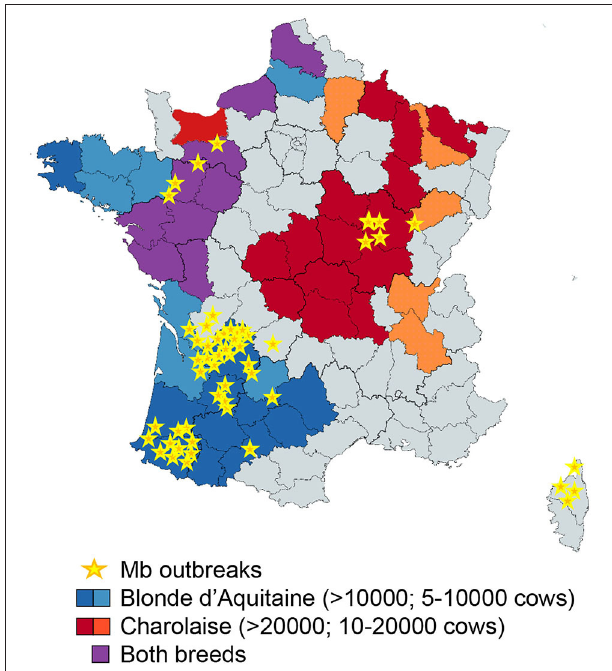
FIGURE 7 | Superposition of Blonde d’Aquitaine and Charolaise beef breeds in French counties where Mb outbreaks were declared between December 2019 and 2020. This map of France shows the counties where Mb outbreaks were declared between December 2019 and December 2020 (yellow stars) and was obtained with data extracted from https://www.plateforme-esa.fr/. Herd densities of Blonde d’Aquitaine (blue), Charolaise (red), or both breeds (violet) were extracted from data obtained from https://www.racesdefrance.fr/ (cows above 3 years old have been